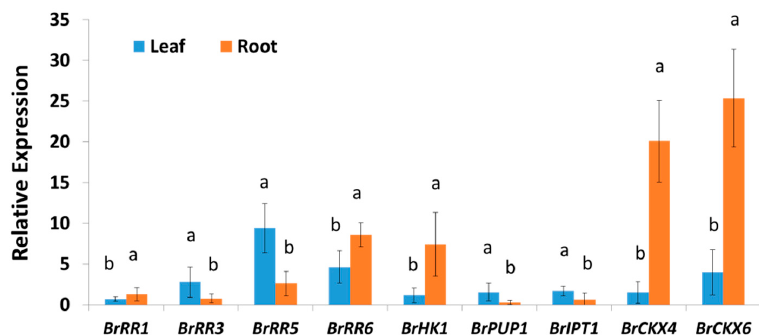
Figure 3. Variation in relative expression of cytokinin regulating, synthesizing, and degrading genes in root and leaf samples. Each data is the average of both inoculated and mock-treated samples at five different time-points (average of 30 samples). Vertical bars represent standard deviations. Letters a and b indicate statistically significant difference between leaf and root samples at 5% level of significance. Gene expression levels in leaves from non-treated plants on Day 0 were set to 1.